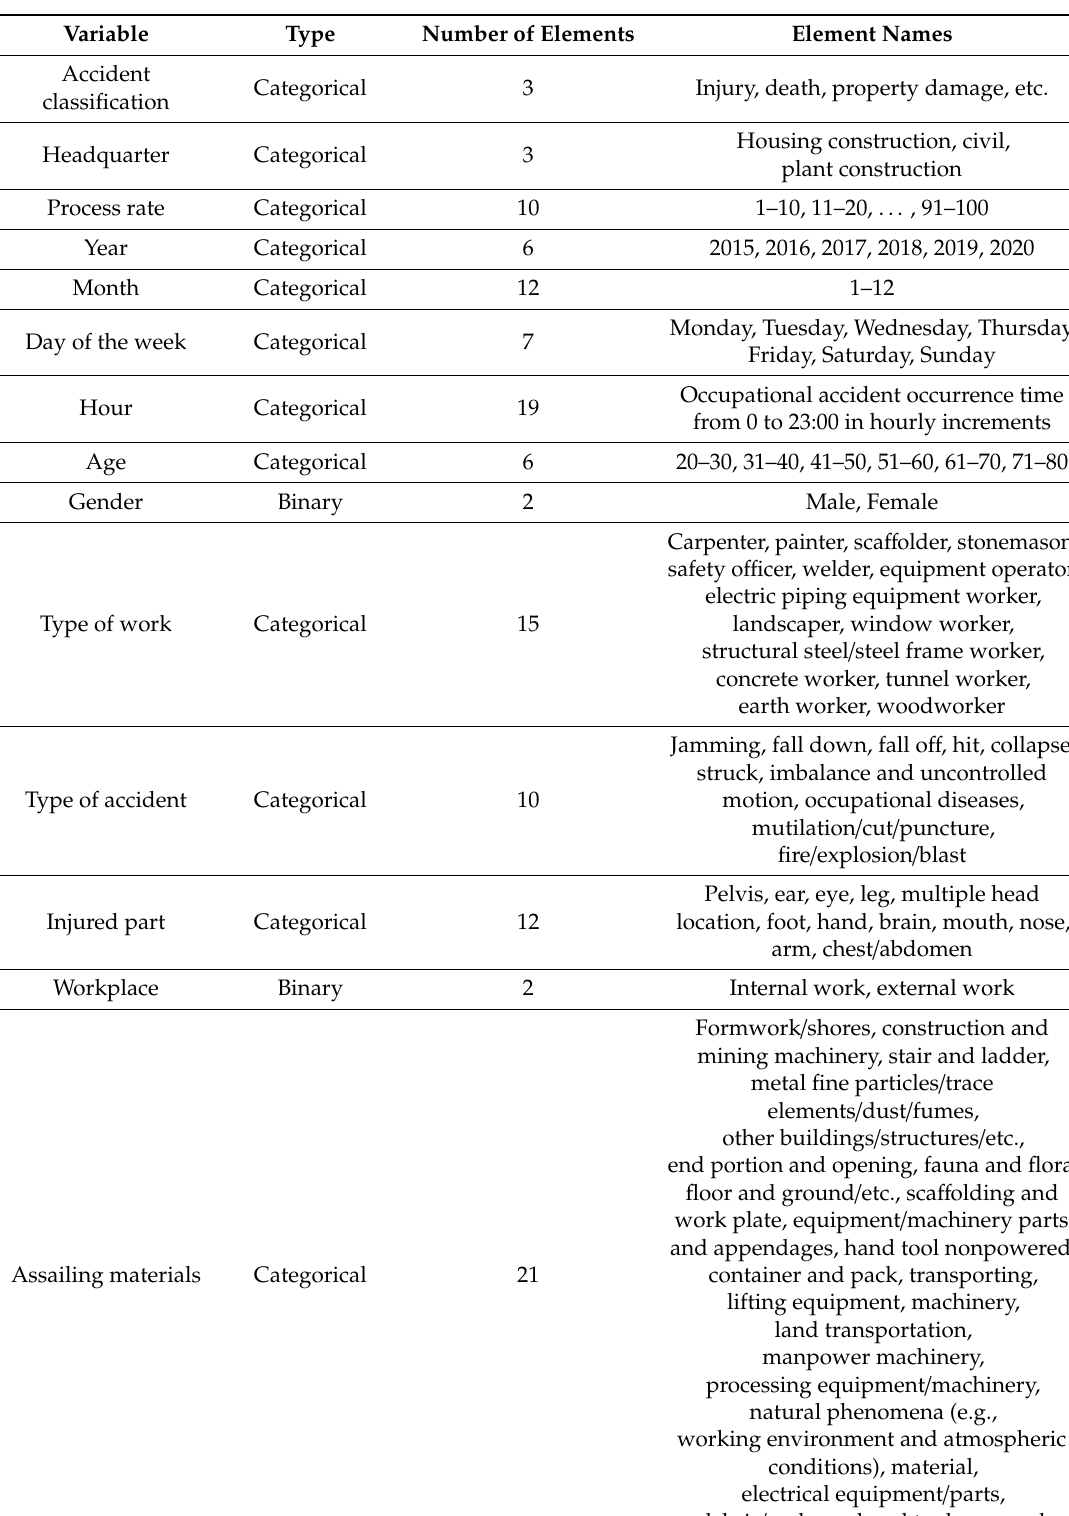
Table 2. Description of variables from 963 occupational accident data